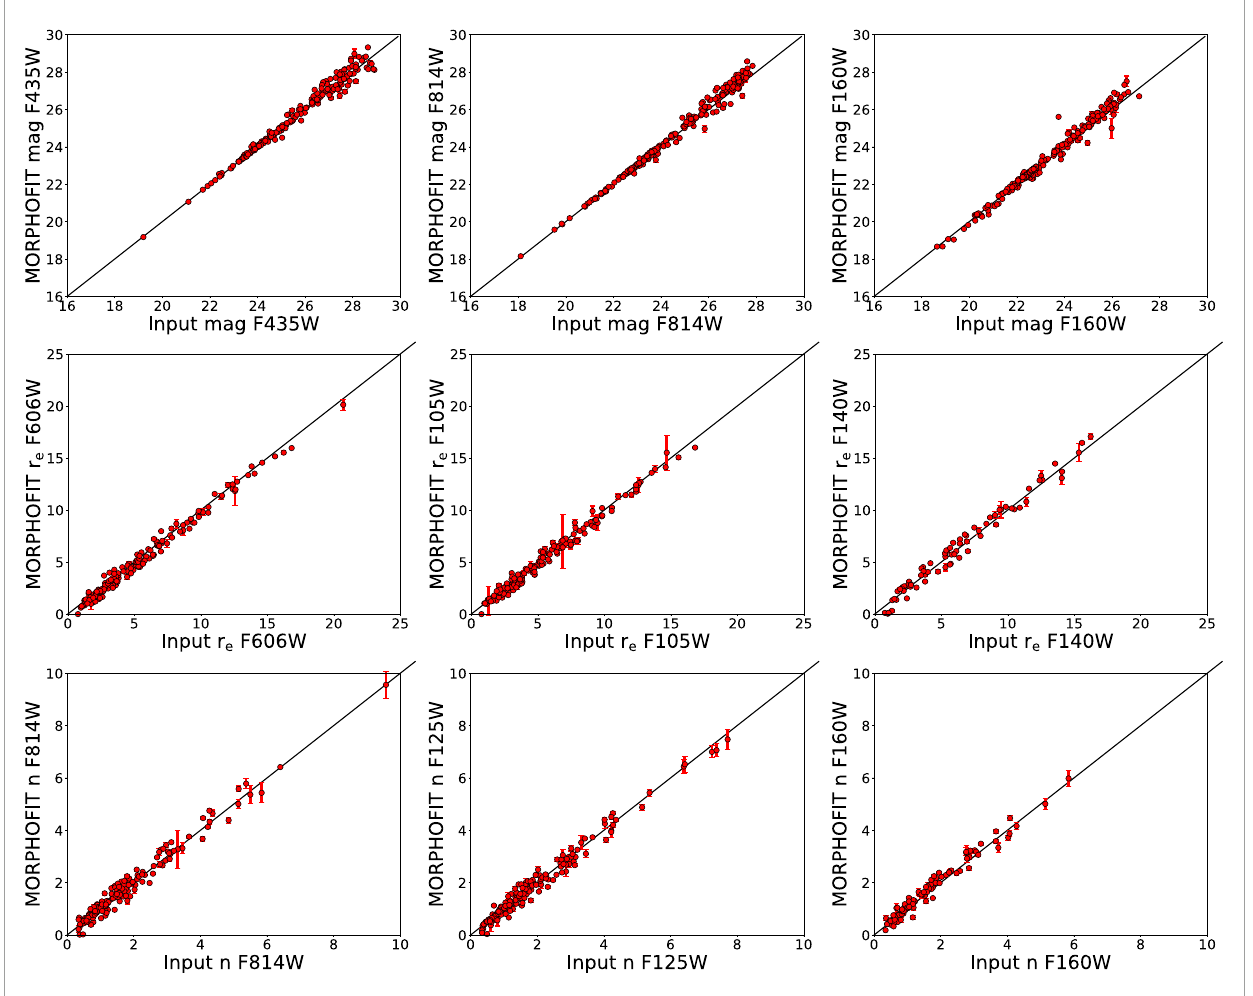
FIGURE 5 The top, middle and bottom panels show the comparison between the input simulated galaxy magnitudes, the galaxy effective radii, the galaxy Sérsic indices and the best-fitting magnitudes, effective radii, Sérsic indices from MORPHOFIT , respectively. Magnitudes are in the AB system, while the effective radii are expressed in units of pixels. mag , r e and n refer to the total magnitude, the effective radius and the Sérsic index of the input and fitted Sérsic profile, respectively. For each row, we only select a sub-sample of the seven wavebands for plot clarity. Red points refer to the simulated target galaxies and their neighbouring objects. The black solid line represents the one-to-one relation between the input and the best-fitting